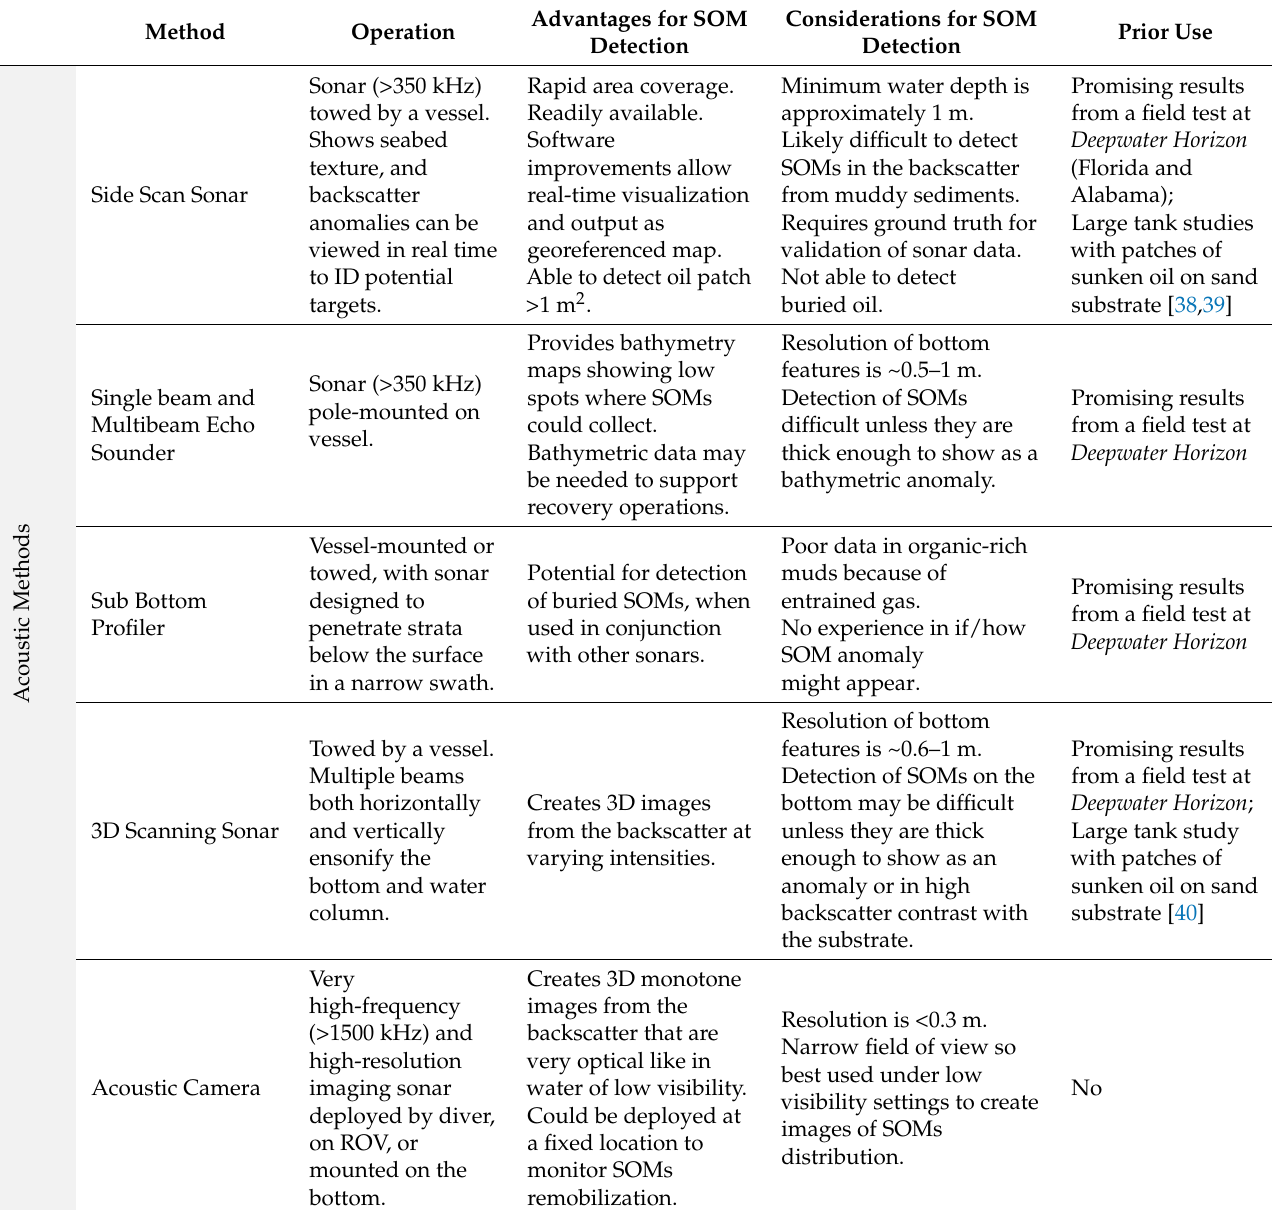
Table 2. SOMs detection using acoustic methods for open-water environments seaward of the surf